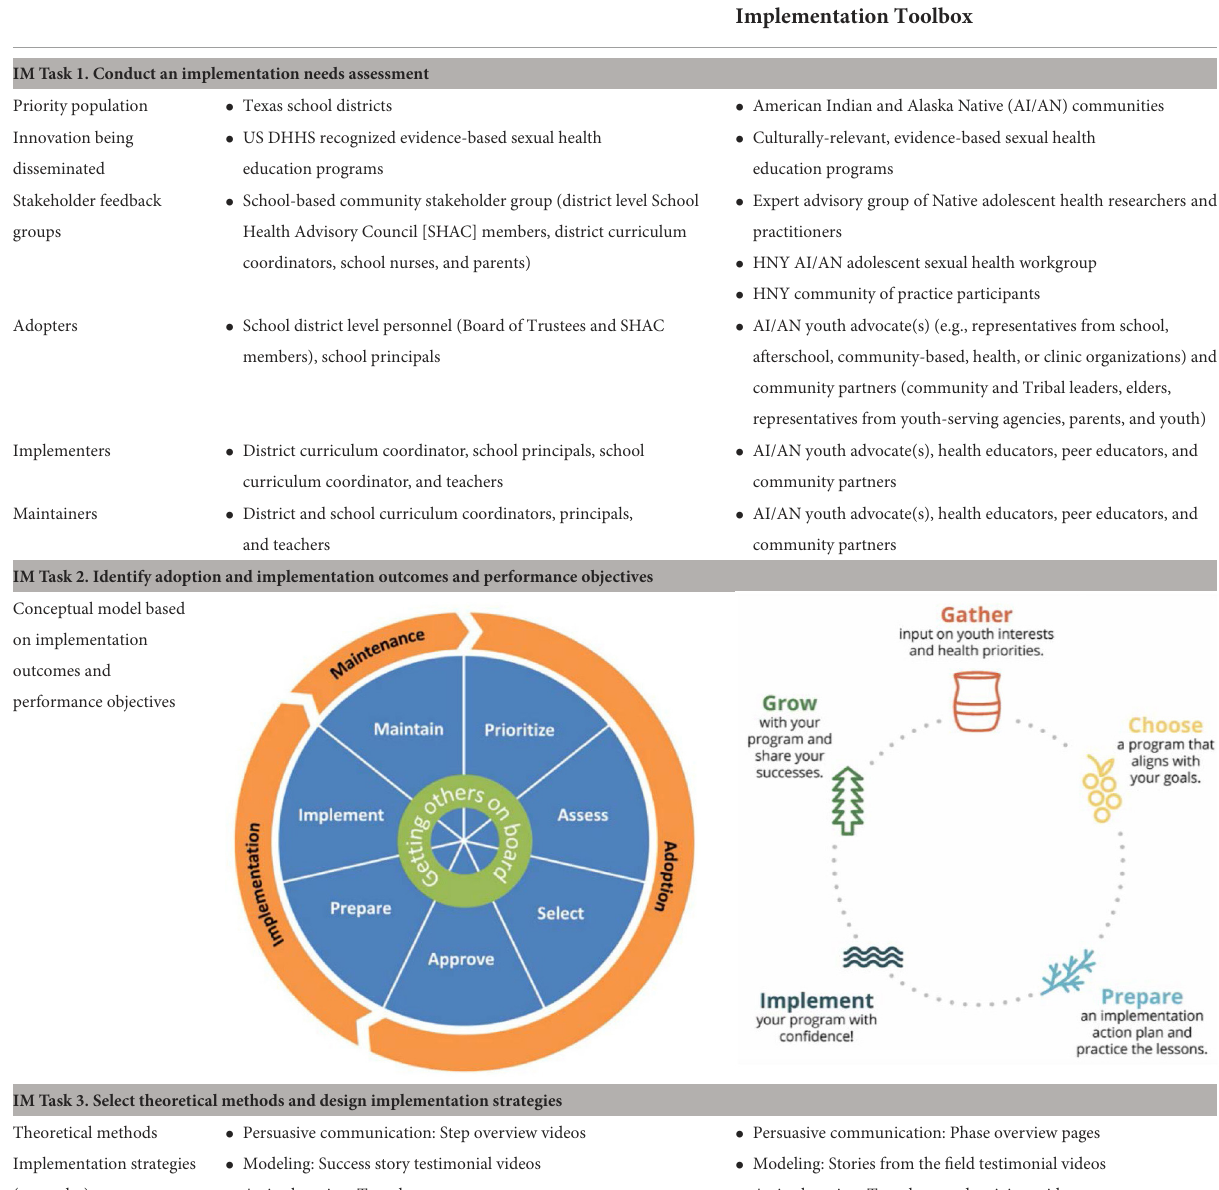
TABLE 6 Summary of Adaptations from iCHAMPSS to the Healthy Native Youth Implementation Toolbox by Implementation Mapping Task. Original